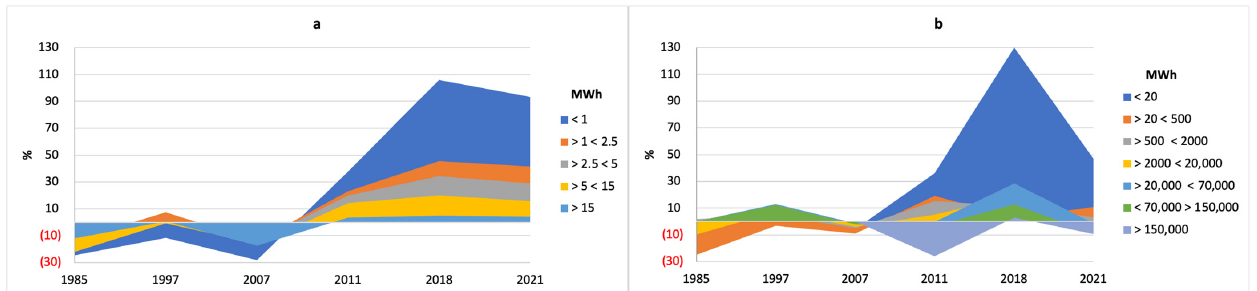
Figure 2. Evolution of domestic ( a ) and industrial ( b ) prices by consumption segments (MWh) with respect to the European average (%). Note: On the horizontal axis, the years studied are collected through six chronological sections from 1985 to 2021 (1985, 1997, 2007, 2011, 2018, 2021). On the vertical axis, we can see with different colours (according to different sections or segments of consumption and in percentage) the Spanish domestic prices (graph on the left) and the industrial prices (graph on the right) with respect to the European average (which in all chronological cuts takes the value 0%). The twelve consumption segments of the legend (five domestic and seven industrial) are expressed in MWh. The Figure offers us two important ideas: (1) First, the average prices (domestic ( a ) and industrial ( b ) until 2007 did not compare very unfavourably with respect to the European average. Since then, both have had a growing and very striking evolution. This reality calls into question whether the theoretical, not real, introduction of more markets would translate into greater transferable efficiency in low prices for consumers. In addition, bringing the subject to the present day, it seems clear that the Ukraine War, as opposed to what some point out, is not the only cause of the increase in current prices. The explanation for this negative evolution of prices has to do, as explained in the text, with the disastrous regulation in the market. (2) The second important idea that can be drawn from reading the Figure is that the largest consumers (domestic ( a ) and especially industrial ( b )) have always been the ones that have had more favourable prices compared to medium- and low-consumption subscribers. Given this strong inequality, it seems reasonable that the less favoured social classes in Spain are especially sensitive to the upward trend in electricity prices and that they demand a drop in rates. In addition, on the contrary, it seems questionable or a better subject to study carefully (although the prices of large consumers are suspiciously secret for researchers) the complaints of capital-intensive industrials for suffering relatively high prices in relation to many other European industrial consumers. Source: Own elaboration based on